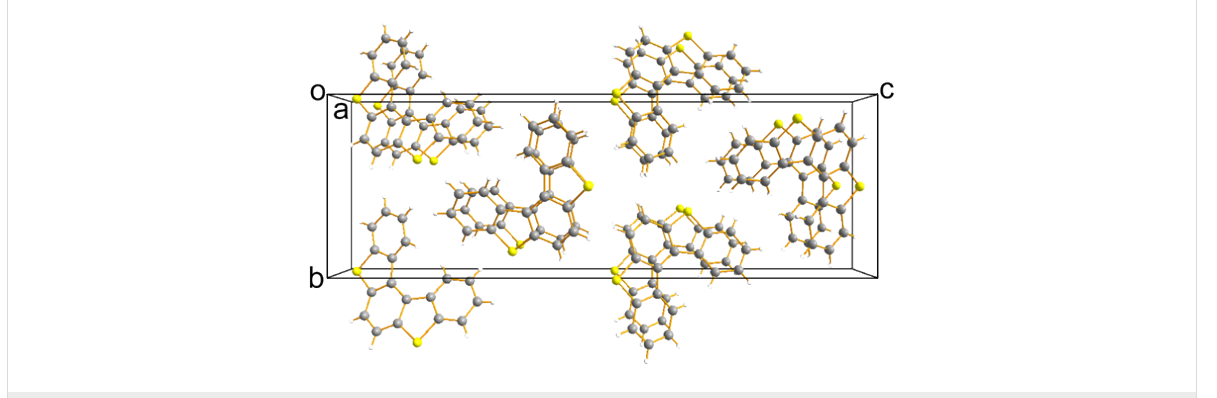
Figure 3: Crystal packing structure of 1 .